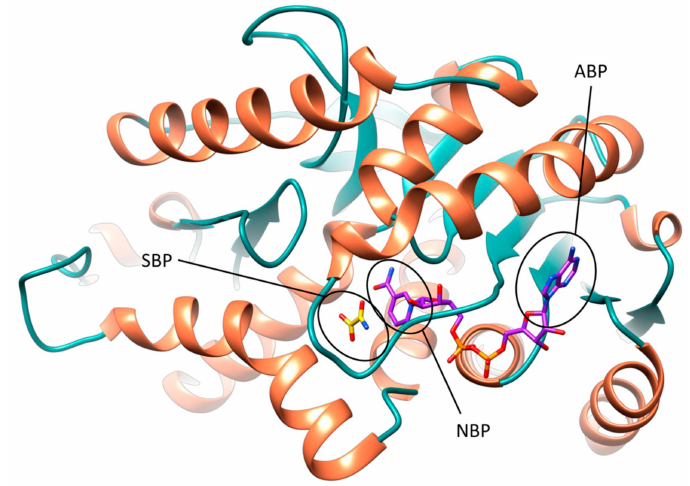
Figure 1. Different subpockets identified within h LDH5 binding groove (closed conformation). The substrate-binding pocket (SPB), nicotinamide-binding pocket (NPB) and adenine-binding pocket (ABP) are highlighted. NADH and 1 are shown in purple and yellow,